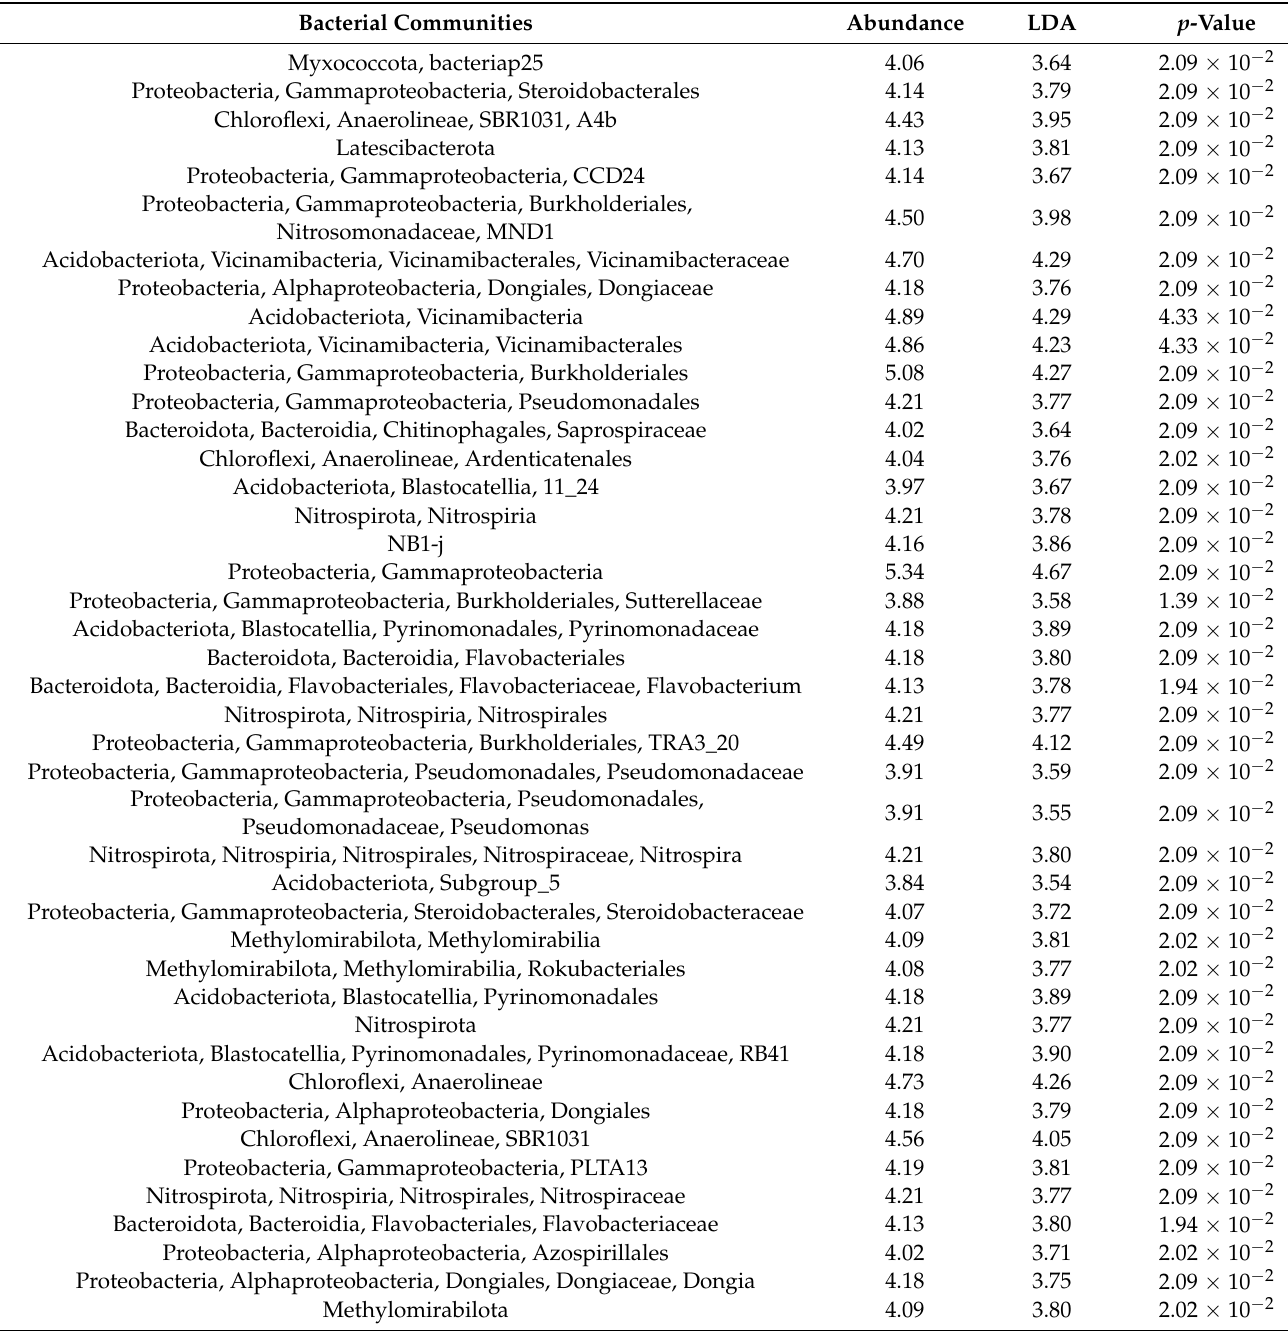
Table 4. Rhizosphere bacterial groups with significant abundance in coastal